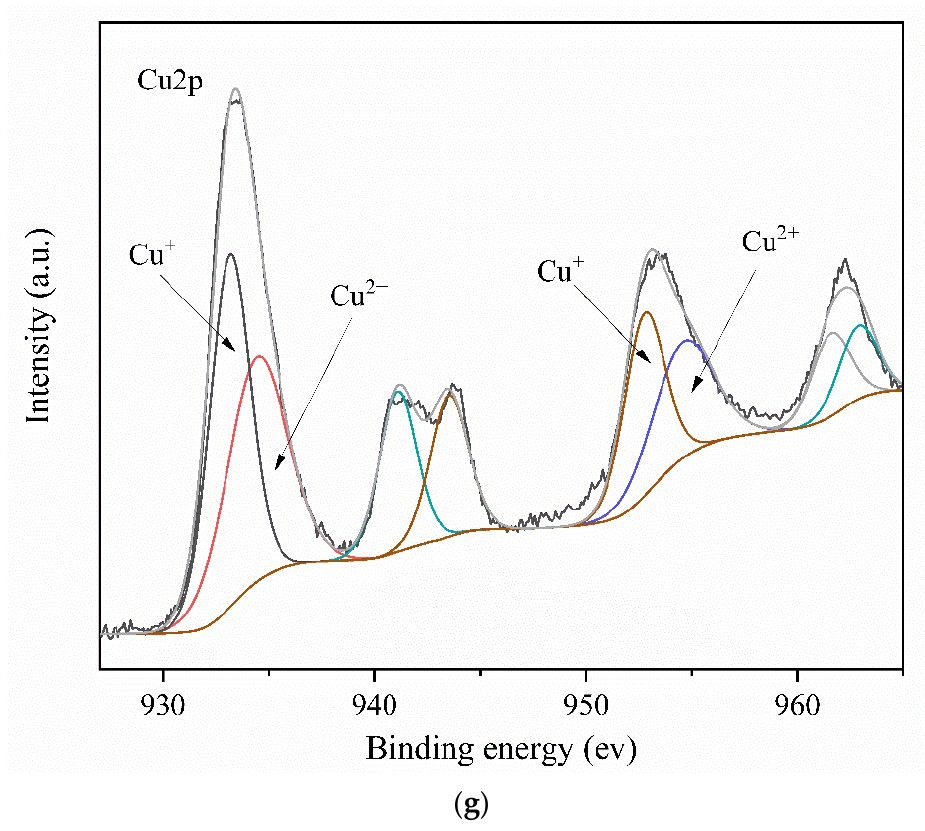
Figure 8. X-ray photoelectron spectroscopy spectra of full survey ( a ), O1s ( b , c ), N 1s ( d , e ), Cu 2p ( f , g ) in the CM/g-C 3 N 4 before ( b , d , f ) and after ( c , e , g ) the reaction.